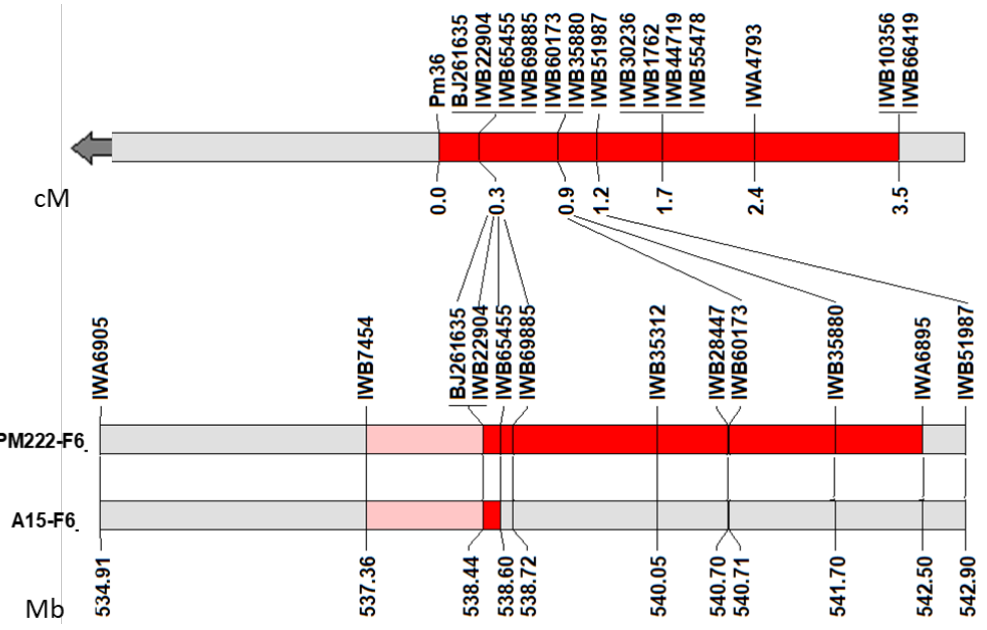
Figure 3. Fine mapping of Pm36 . ( a ) Genetic linkage map of the 5BL chromosome region harboring Pm36 generated in the 5BIL-42 x Latino F 2:3 progeny population. The grey and red regions represent the durum and the dicoccoides chromosomal segments, respectively. Marker loci are listed above and genetic distances in cM are shown at the bottom of the chromosome bar. The arrow point to the centromere; ( b ) Secondary recombinant homozygous lines (A15-F6 and PM222-F6) including introgressed dicoccoides chromosomal regions shorter than the 5BIL-42 one; the pink segments indicate the chromosomal interval harboring Pm36 . Marker loci are listed above and physical distances in Mb are shown at the bottom of the chromosome bar. The lines connect the common markers between the genetic map and the physical map of the secondary recombinant lines.